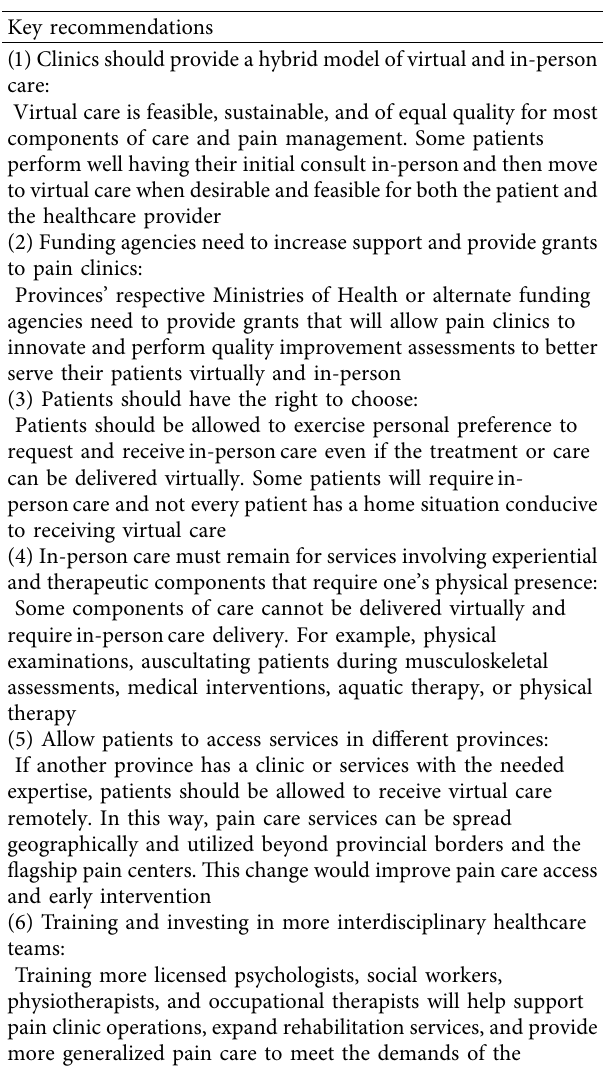
Table 2: Postpandemic recommendations for virtual care services at pain